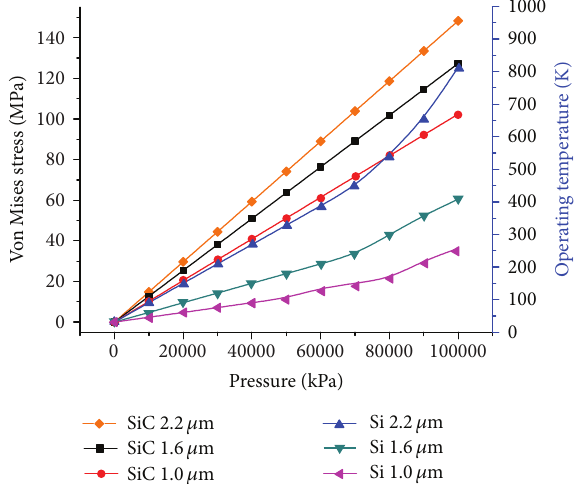
Figure 15: Comparison of von Mises stress versus differential pres- sure and temperature for 3C-SiC and Si with differential thickness of